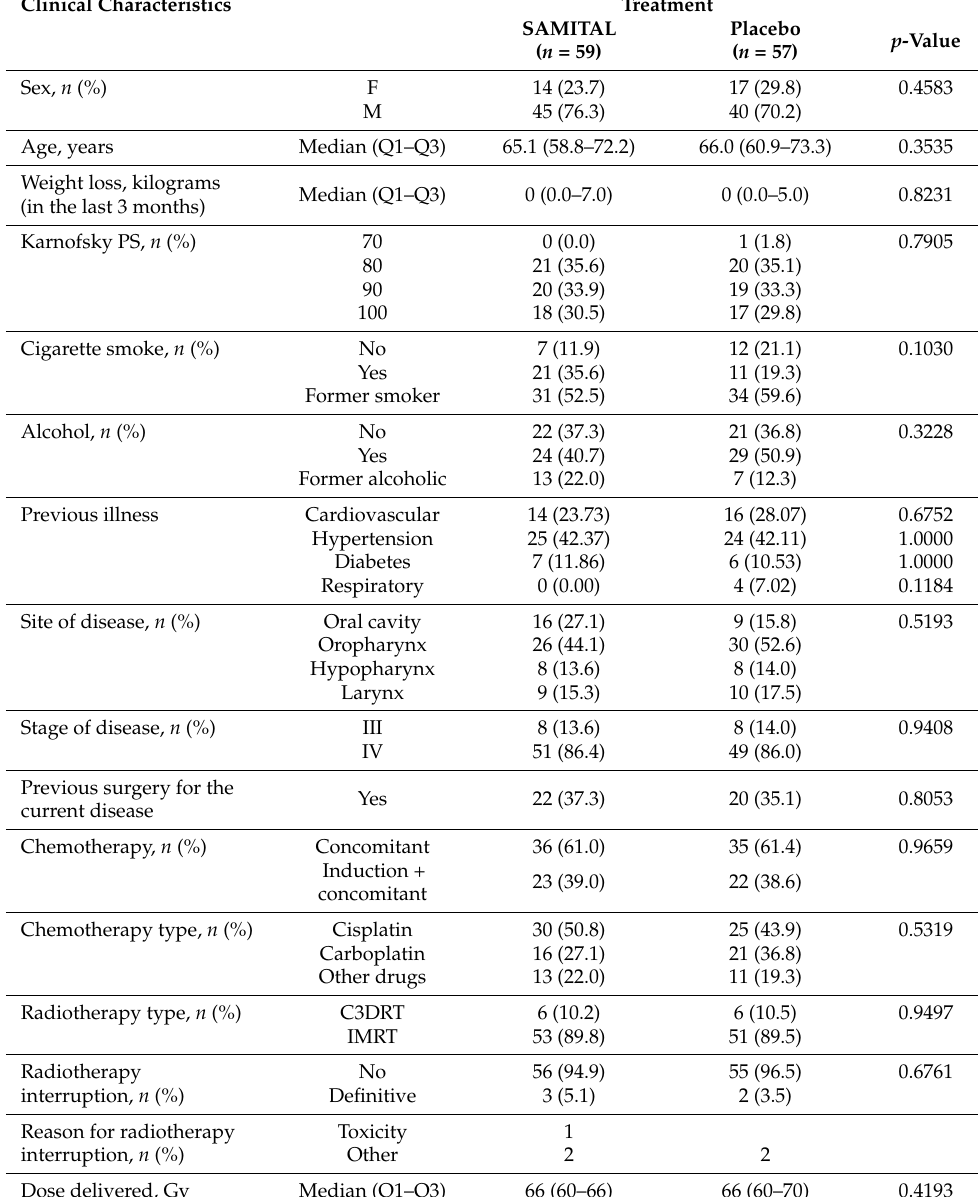
Table 1. Clinical and cancer treatment characteristics by the randomized